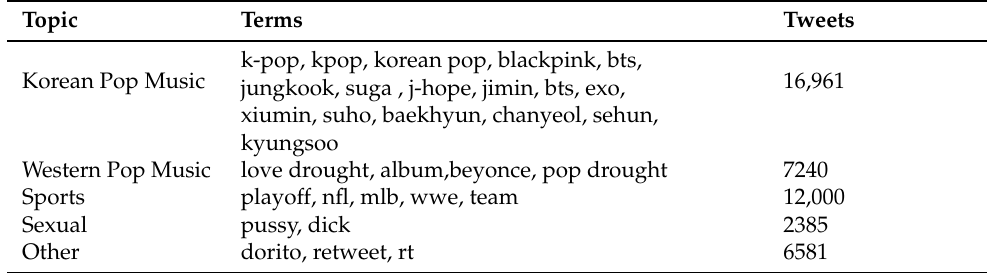
Table A2. Through inspecting manually classified irrelevant tweets, there were five common irrele- vant tweet topics. Key terms within each topic were compiled into a list and if a tweet contained any of these terms, it was